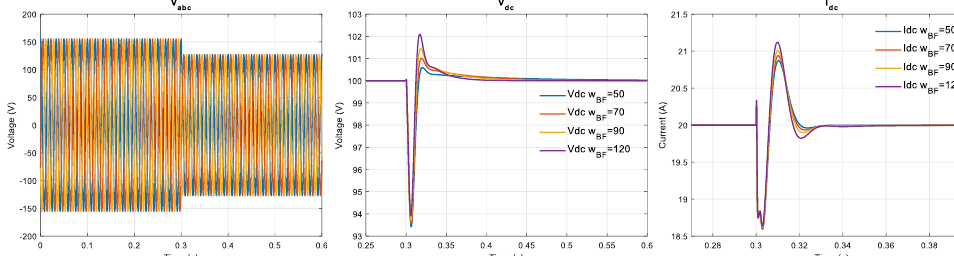
Figure 11. Simulation results when the rms grid voltage drops from 110 V to 90 V with an ouptut voltage regulation at 100 V: grid voltages V abc on the ( left ), output voltage V dc in the center, and output current I dc on the ( right ). Parameters are listed in Tables 1 and